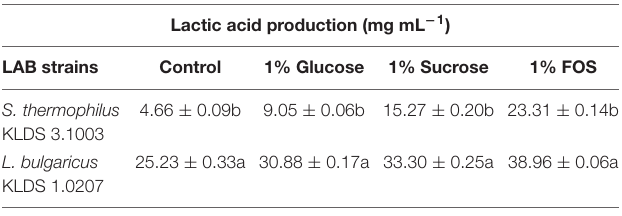
TABLE 1 | Effect of carbon source on lactic acid production of S. thermophilus KLDS 3.1003 and L. bulgaricus KLDS 1.0207.